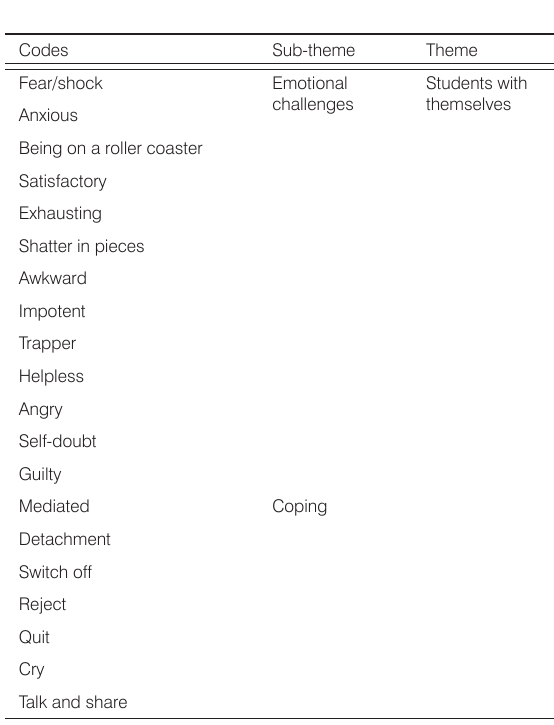
Table 3. The example of meta-synthesis for one theme of nursing students for caring for dying patients and their families.